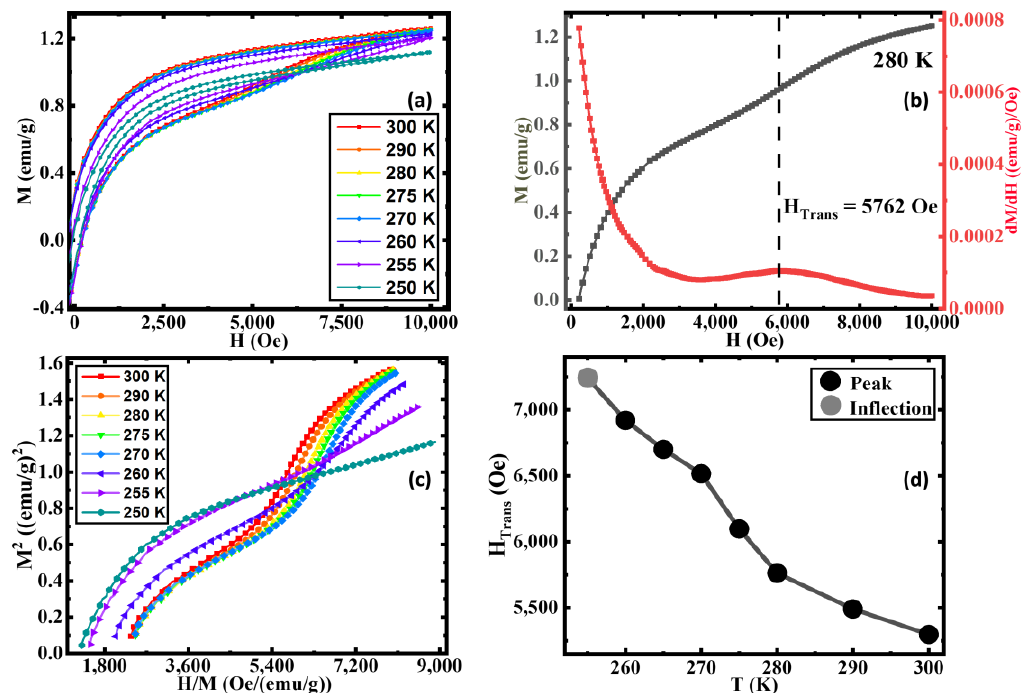
ple at selected temperatures above and below the MT. As shown in Figure 4a, the slope change in M(H) associated with the metamagnetic transition becomes stronger with de- creasing temperatures up to ~275 K, below which it slowly weakens and disappears at T = 250 K. Usually, metamagnetic transitions are first-order transitions. To understand the order of the field-induced metamagnetic transitions in our AN sample, we show Arrott plots for 9 h annealed samples at selected temperatures in the range of 250 K ≤ T ≤ 300 K in Figure 4c. In the case of a first-order metamagnetic transition, the fourth-order coeffi- cient of the Landau free-energy expansion becomes negative giving rise to the appearance of an inflection point/negative slope accompanied by an S-shaped curve of the Arrott plot [63,64]. It is evident that the Arrott plots for our 9 h AN exhibit S-shaped curves along with an inflection point and the negative slope in the field range of 5400 Oe ≤ H ≤ 7200 Oe at temperatures in the range of 260 K ≤ T ≤ 300 K which further confirms the occurrence of field-induced first-order metamagnetic transition in this sample [60]. The S-shape be- havior of the Arrott plots disappears for T ≤ 255 K. We estimated the transition field asso- ciated with the metamagnetic transition (H Trans ) from the first derivative of the increasing branch of the isothermal magnetization curve, as indicated in Figure 4b. Clearly, H Trans shifts to higher fields with decreasing temperature and eventually disappears below 255 K, as shown in Figure 4d.